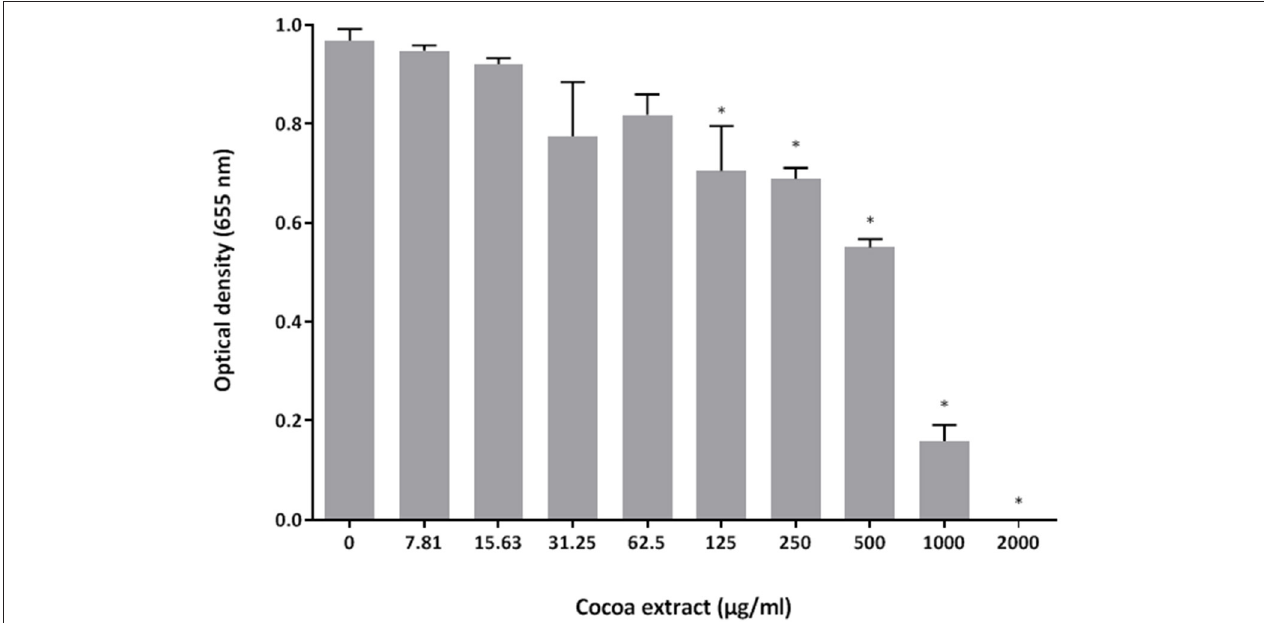
FIGURE 1 | Effect of the cocoa extract on the growth of P. gingivalis . Bacterial growth was monitored by recording the optical density at 655nm following a 24-h incubation at 37 ◦ C under anaerobiosis. *significant inhibition ( p < 0.01) compared to the control (no cocoa extract).